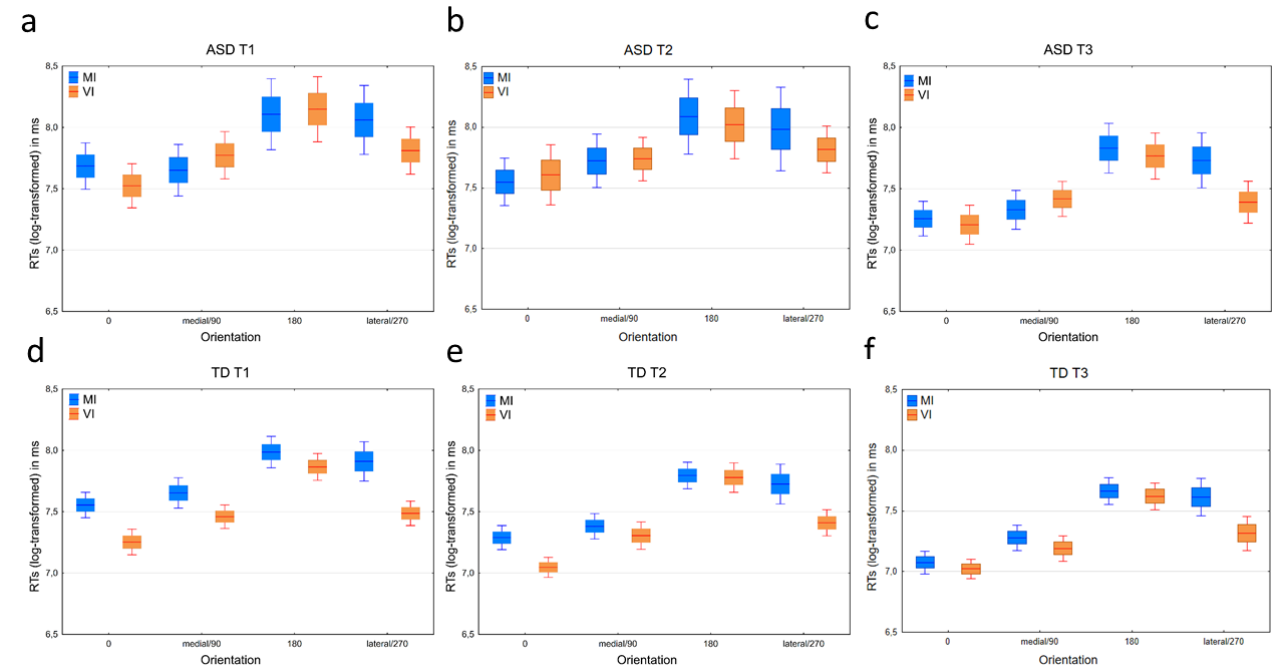
Figure 2. RTs (log-transformed) in separate graphs for the different orientations and tests by the age levels (A1 ( a ) and ( d ); A2 ( b ) and ( e ); and A3 ( c ) and ( f )) and groups (ASD ( a – c ) and TD ( d – f )). Means are indicated by the lines, standard errors by the box and 95% confidence intervals by the whiskers. Table 2. Main effects and factorial contrasts organized by test type.